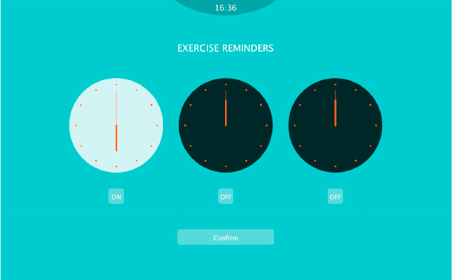
Figure 5. To personalize the reminder settings, the user can rotate the hands of the clock to set reminder options for the timing of three alarms during the working date.